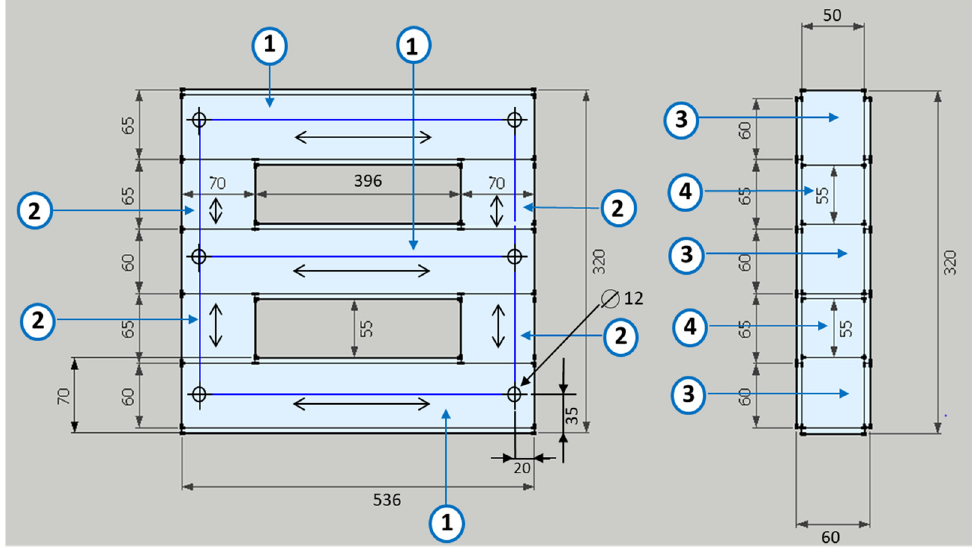
Figure 1. Main dimensions of the transformer. Dimensions of steel plates (mm): 1. 60 × 536; 2. 70 × 65; 3. 70 × 536, 4. 70 ×